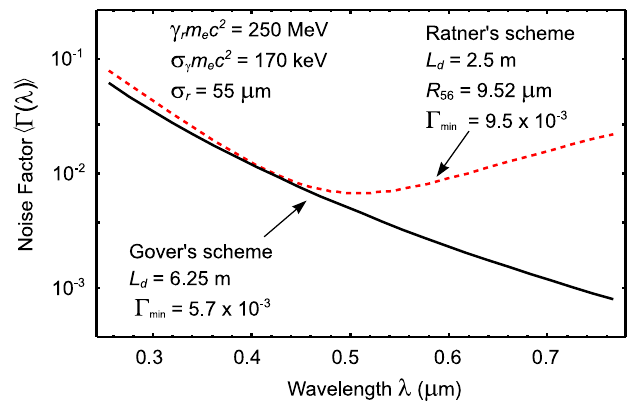
FIG. 16. Noise factor vs wavelength for two noise suppression schemes. The black solid line stands for the noise factor for the scheme employing only a drift channel (Gover’s scheme) whereas the red dotted curve stand for the noise factor for the scheme employing a drift channel and a chicane (Ratner’s